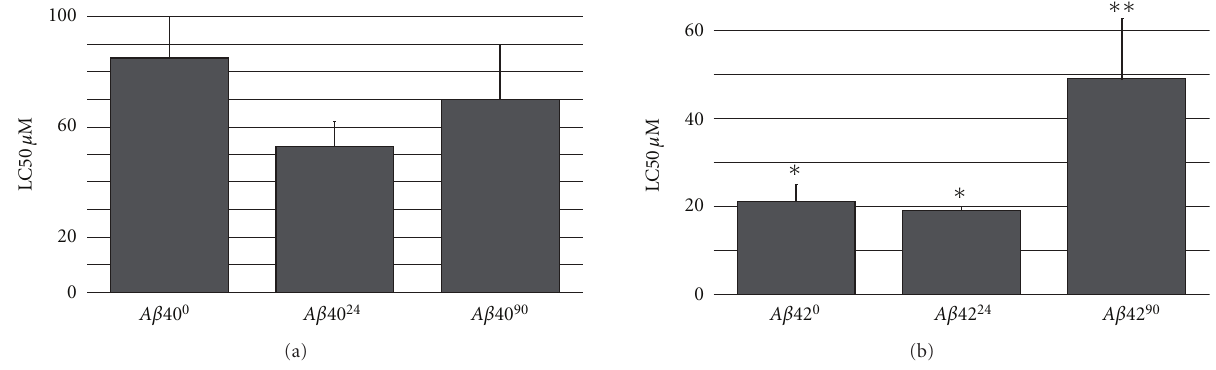
Figure 10: Relative toxicity of endocytic A β . Lethal concentration of endocytic A β required to kill 50% of di ff erentiated PC12 cells at 48 hours is shown. Error bars represent the standard deviation from the mean using three replicates. Statistical significance is indicated ( ∗ ) P < . 05.